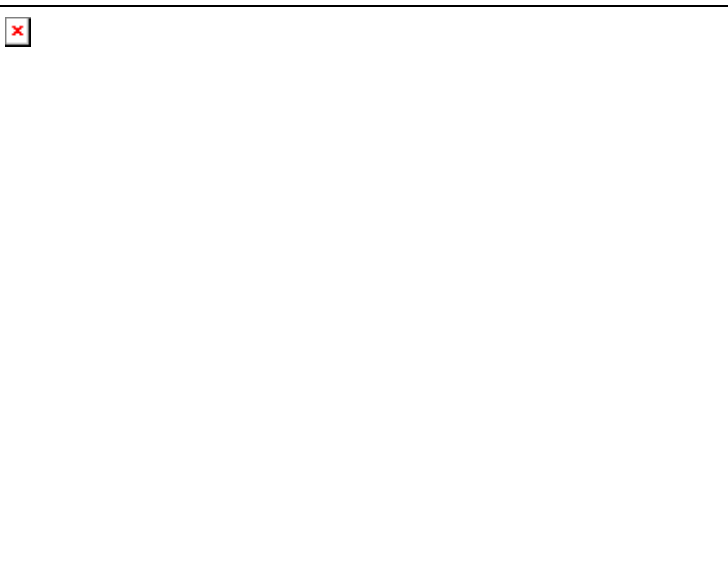
(red) as a function of JPD. A linear y ) = 0.94, R 2 (a x